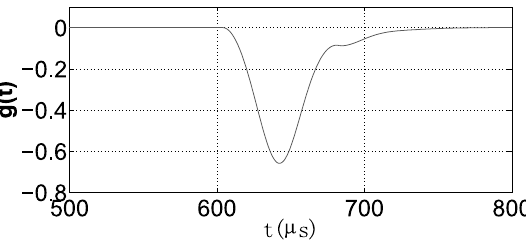
Fig. 29. Echo predicted by the SAA model for the experimental